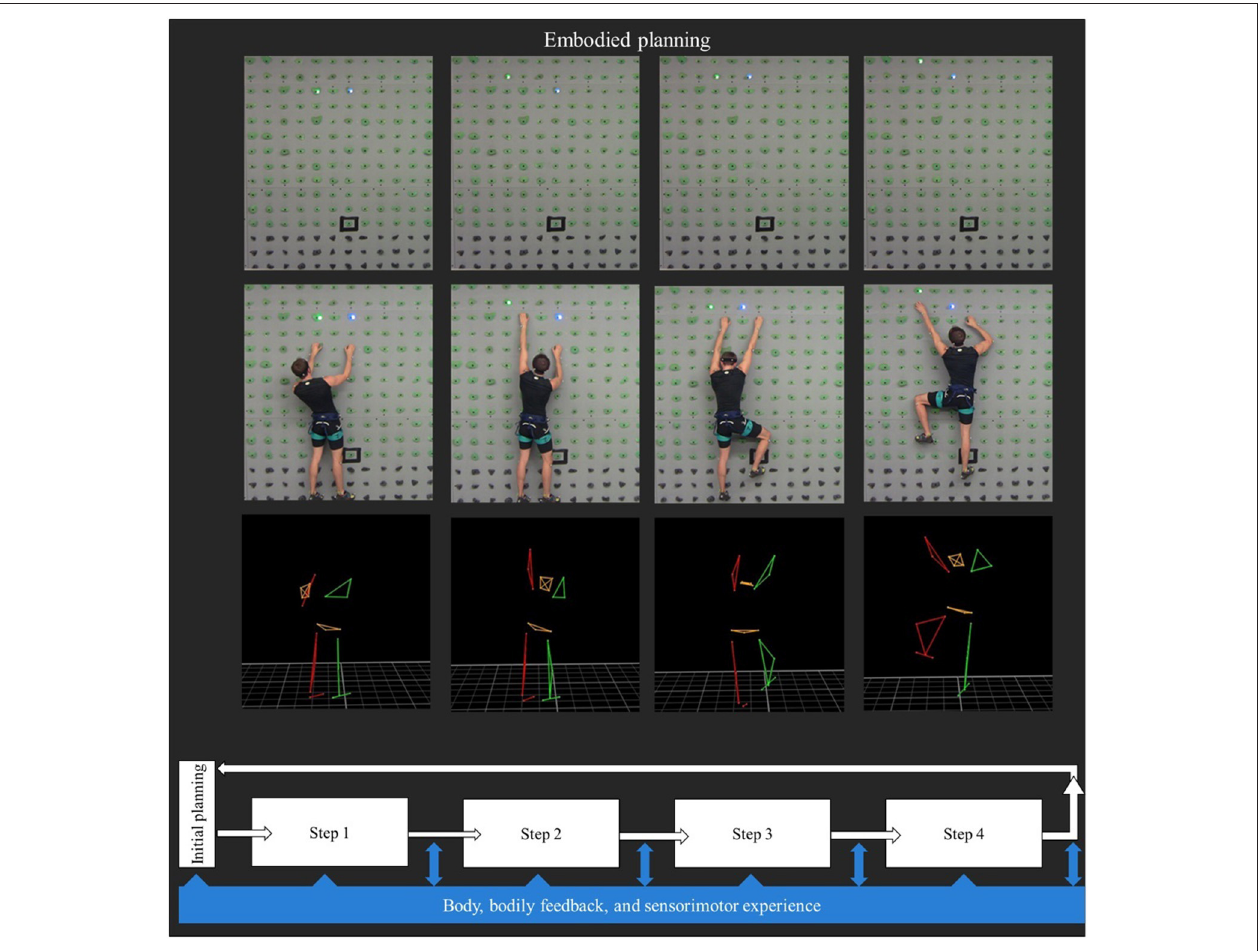
FIGURE 1 | Embodied planning in a climbing paradigm. The figure depicts four steps of embodied planning during a goal-directed climbing task. At the bottom, the embodied-planning concept is modeled as a dynamic, continuous feedback-loop between motor and cognitive planning. The two upper panels show an interactive climbing wall (2.40–3.60 m) with touch-sensitive climbing holds, which can light up in different colors and capture reaction times (i.e., ClimbLing system). The climbing system is synchronized to a movement-analysis system (Vicon; 10 infrared cameras at 119.88 Hz, VICONTM, Oxford, UK), which captures full-body movement kinematics as indicated by the stick figure of the